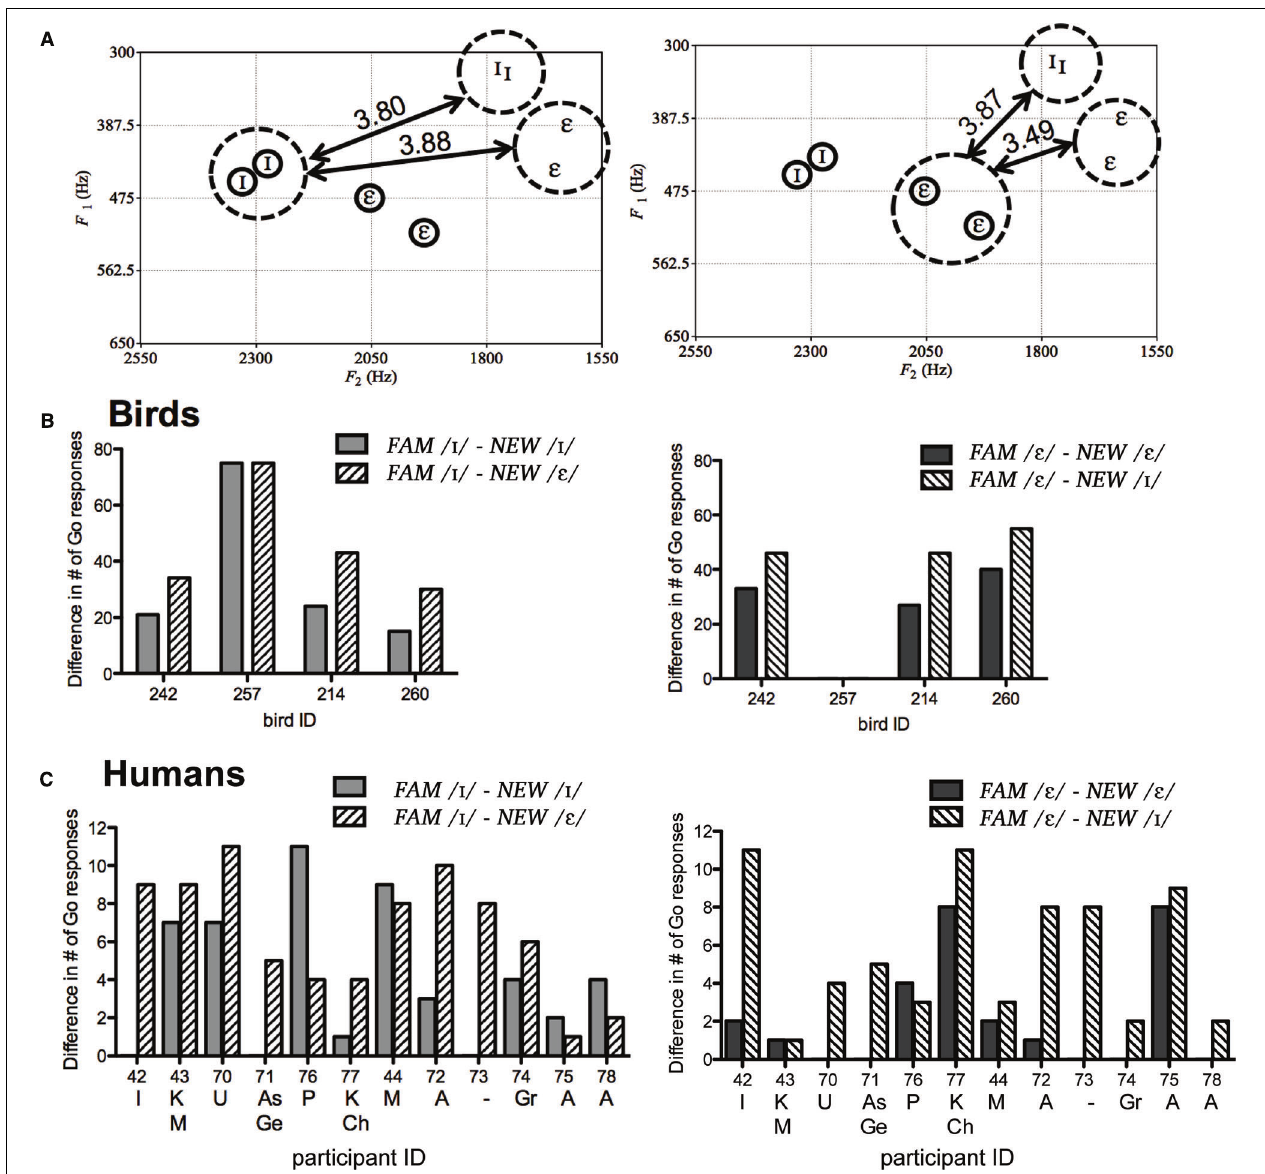
FIGURE 4 | Plots of acoustic distances between FAM (circled) and NEW vowels in the G2 stimulus set of the gender normalization experiment (A) show that acoustic distances within and between vowel categories of familiar and unfamiliar speaker are highly similar and thus likely an unreliable cue for category membership. Still, birds (B) and humans (C) show differences in response to NEW vowels when the